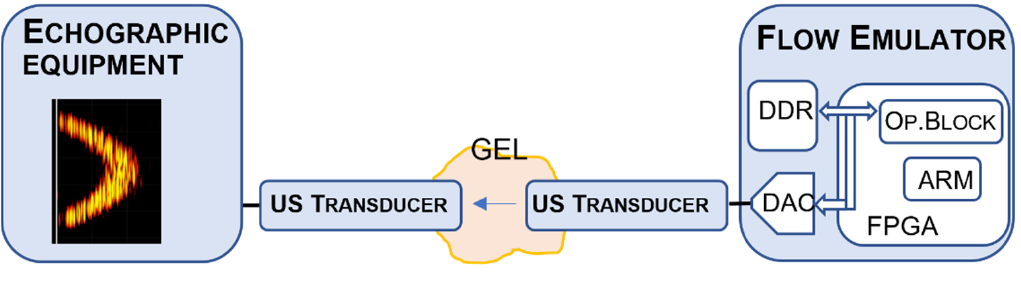
Figure 4. Acoustic coupling between the flow emulator based on the SG IP and an echograph system.